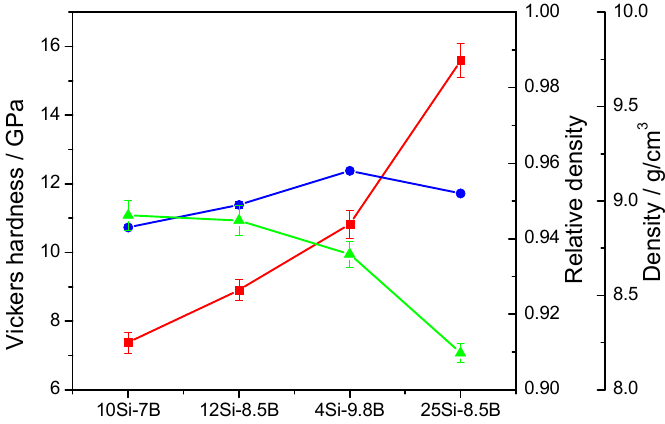
Figure 3. Vickers hardness and density of 10Si-7B, 12Si-8.5B, 14Si-9.8B, and 25Si-8.5B alloys.